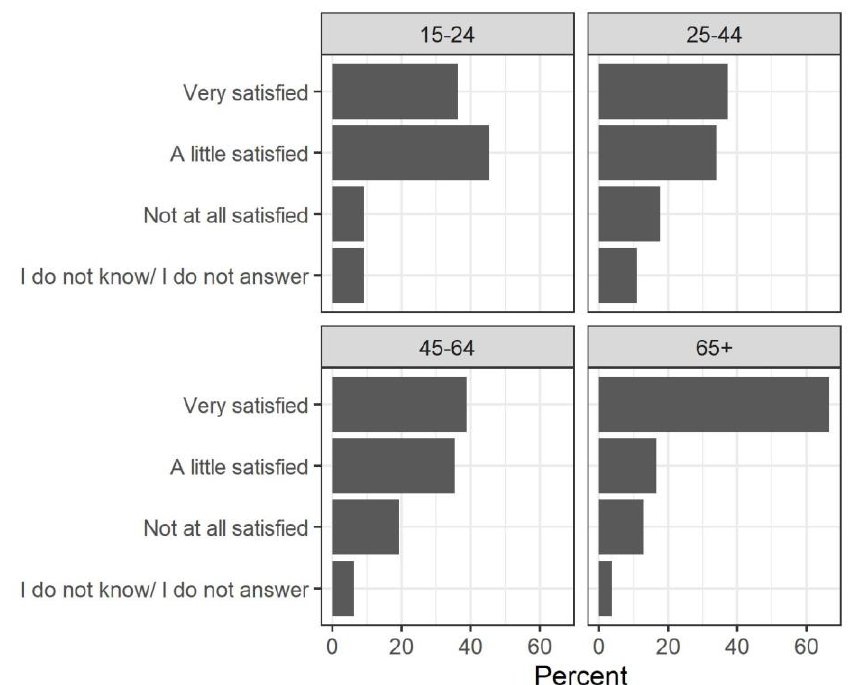
Figure A9. Cross-tabulation of attitudes of believers about the reopening of the Churches by age (% by age). X 2 = 20.43, df = NA, p = 0.013 (Pearson’s Chi-squared test with simulated p -value based on 2000 replicates).